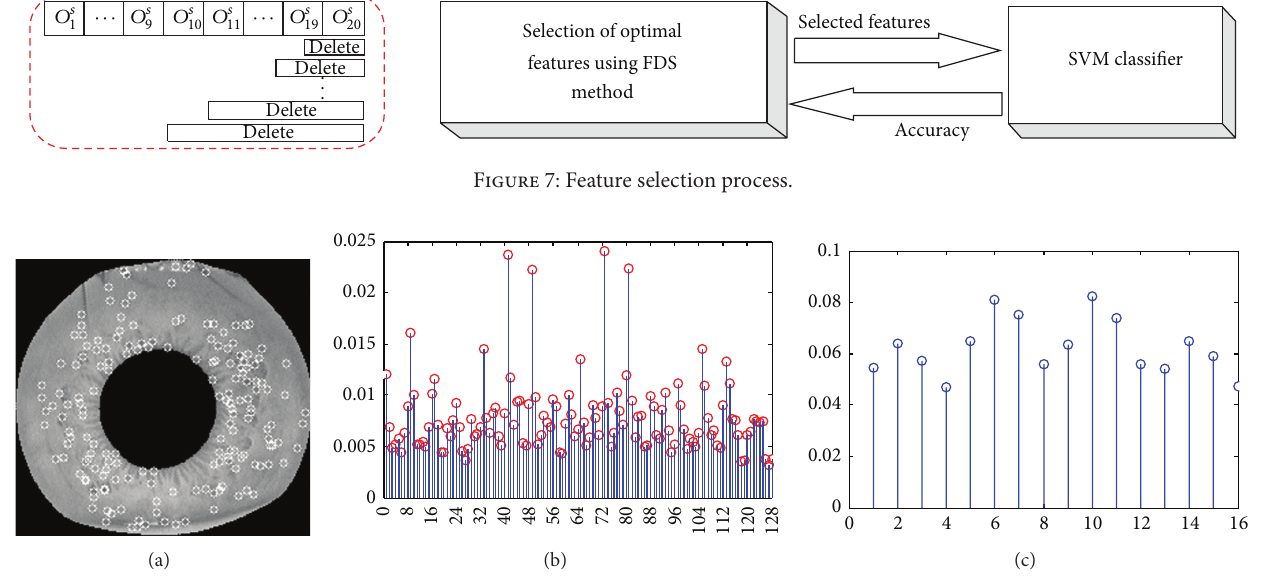
Figure 8: PDF of keypoints’ feature descriptor. (a) The detected keypoints, (b) FDPDF (c)